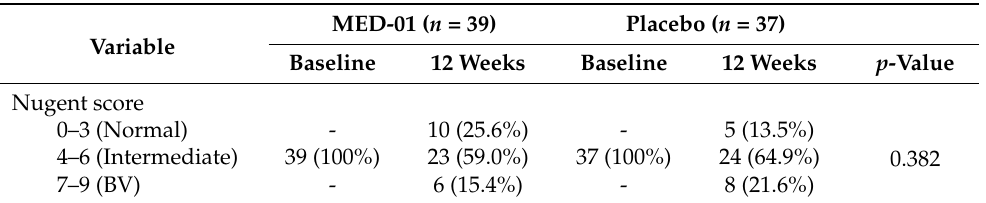
Table 3. Number of participants with bacterial vaginosis (BV) status after consuming of food supplements as determined by the Nugent scores in the MED-01 and placebo groups.